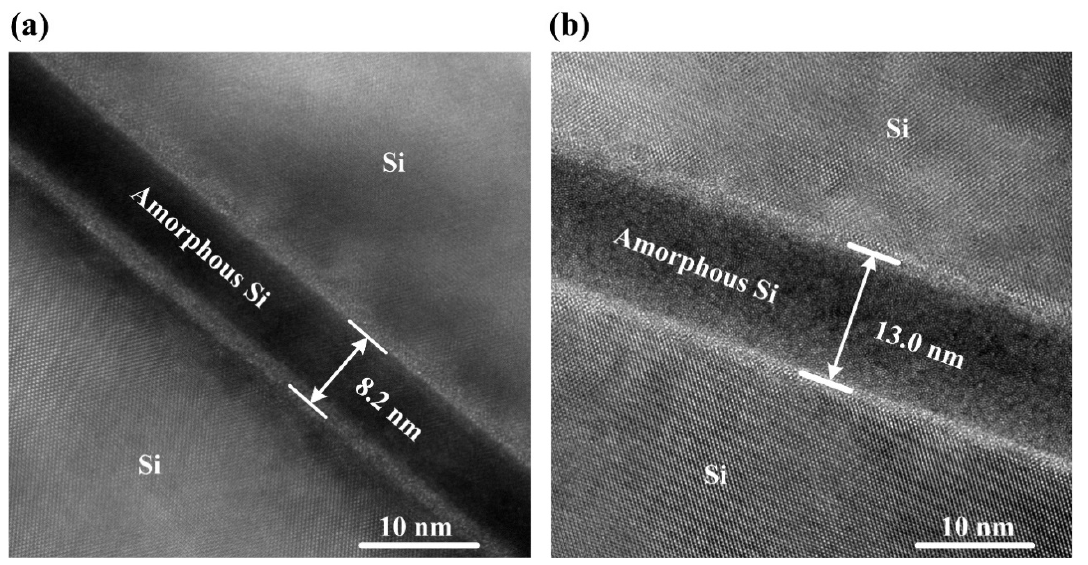
Figure 6. High-magnification cross-sectional TEM images (5 × 10 5 times) of the bonding interfaces in the two bonded Si-Si specimens activated under the Ar ion beam currents of ( a ) 10 mA and ( b ) 30 mA.